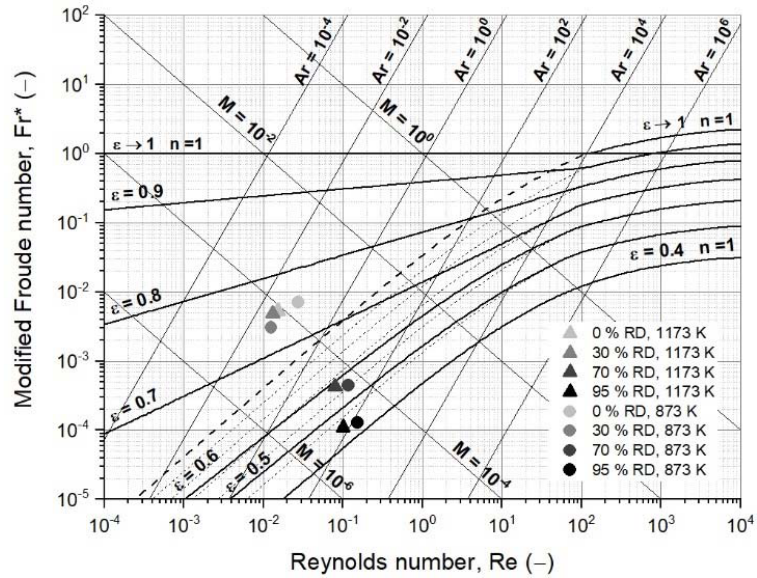
Figure 7. Extended fluidized state diagram following Reh’s approach, including process data for the formation of agglomerates [48].